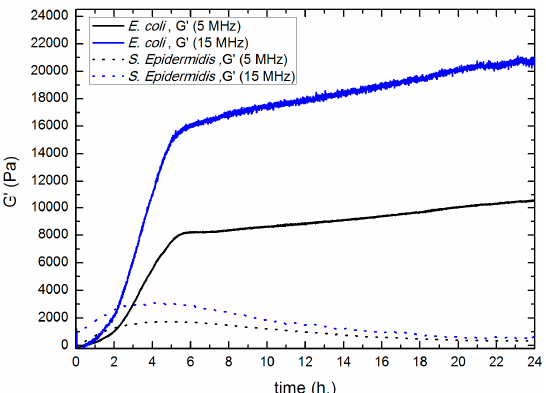
Figure 10. Evolution of the real shear modulus for 5 MHz (black) and 15 MHz (blue). Biofilm formed by S. epidermidis and E. coli are represented by dot line and solid line, respectively.